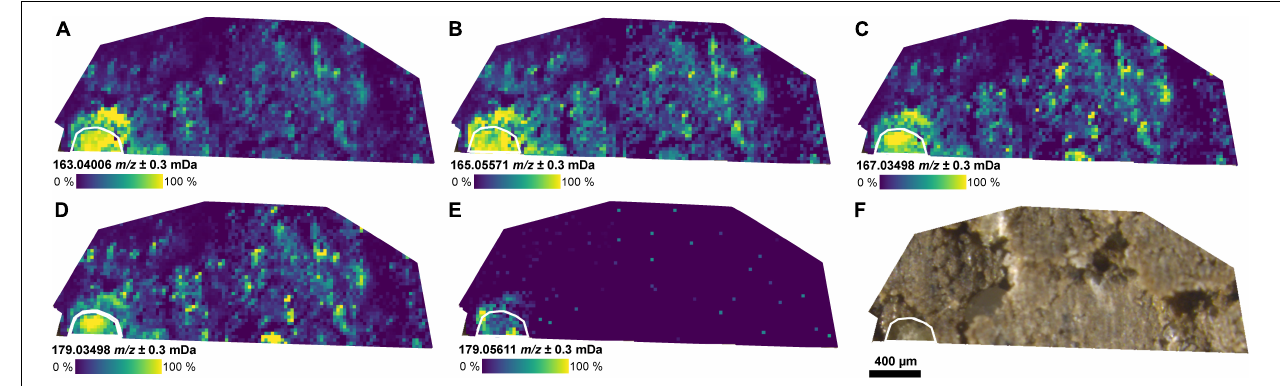
FIGURE 3 | Distribution of small metabolites in the rhizosphere. (A–E) Ion images for metabolites co-localized with the position of the root as detected by LDI-FT-ICR-MSI of an undisturbed soil sample from the field experiment (FP2-d) and annotated via METASPACE: (A) [C 9 H 8 O 3 − H] − ( m/z 163.0401, e.g., coumaric acid), (B) [C 9 H 10 O 3 − H] − ( m/z 165.0557), (C) [C 8 H 8 O 4 − H] − ( m/z 167.0350, e.g., vanillic acid), (D) [C 9 H 8 O 4 − H] − ( m/z 179.0350, e.g., caffeic acid), (E) [C 6 H 12 O 6 − H] − ( m/z 179.0561, e.g., glucose), and (F) optical image of the soil section. The root surface is highlighted in